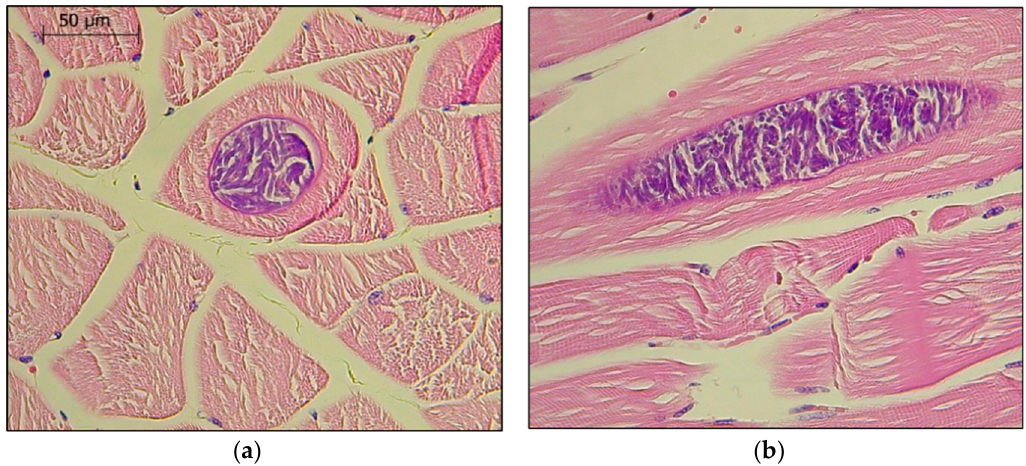
Figure 2. Neospora caninum tissue cysts in the skeletal muscles of the front limb of Donkey 1: ( a ) Figure2. Neosporacaninum tissuecystsintheskeletalmusclesofthefrontlimbofDonkey1: ( a )transverse transverse section; ( b ) longitudinal section. Giemsa, ×100 0 . section; ( b ) longitudinal section. Giemsa, ×